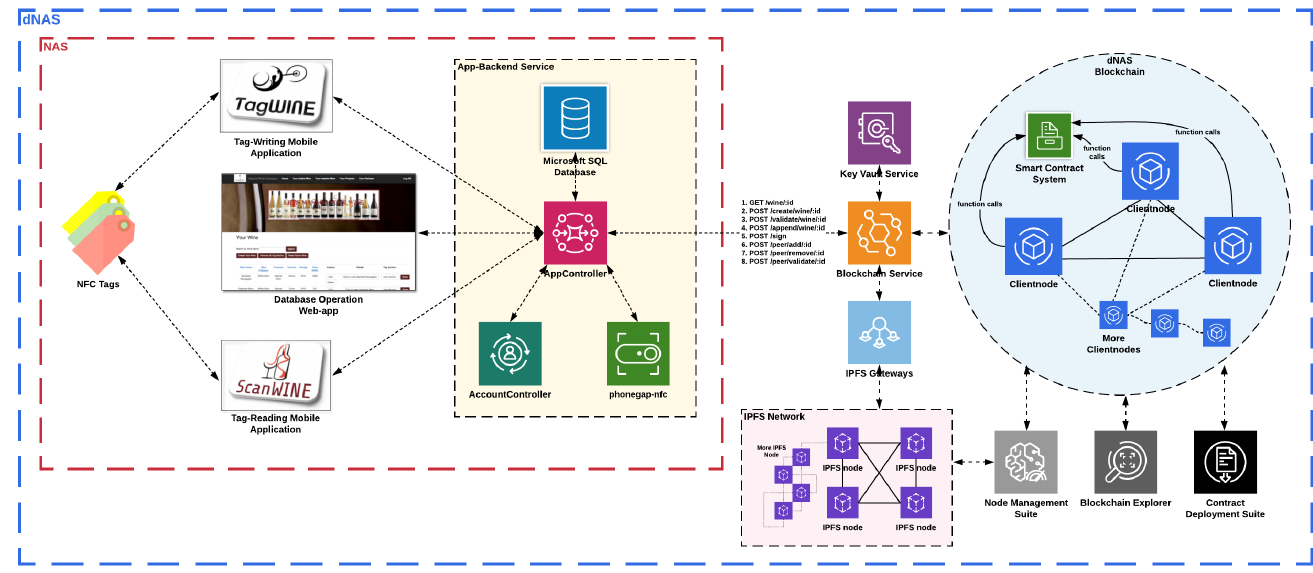
Figure A3. System Architecture Diagram of